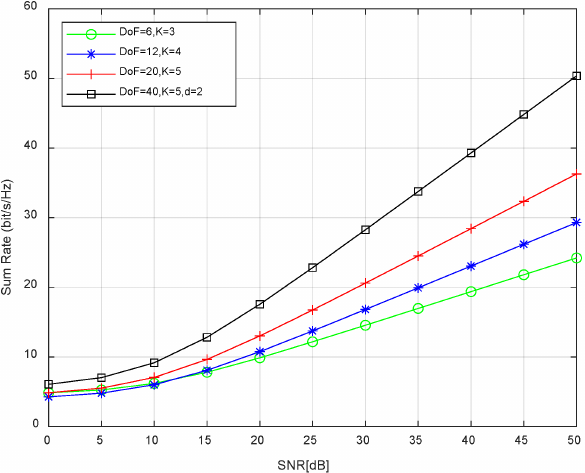
Figure 10. Sum rate of space